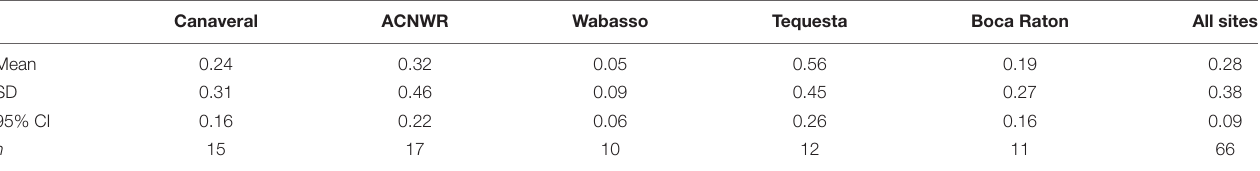
TABLE 2 | Mortality as a mean proportion for nests at each site, and across all sites. Canaveral